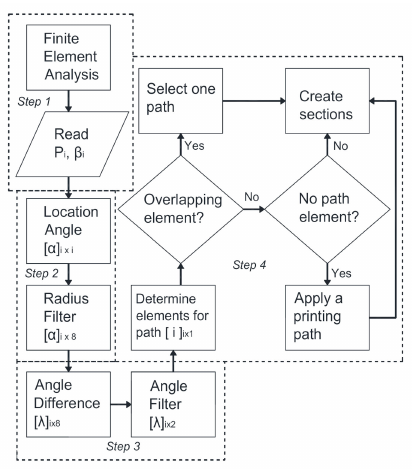
Figure 11. Principal directions of elements [36].